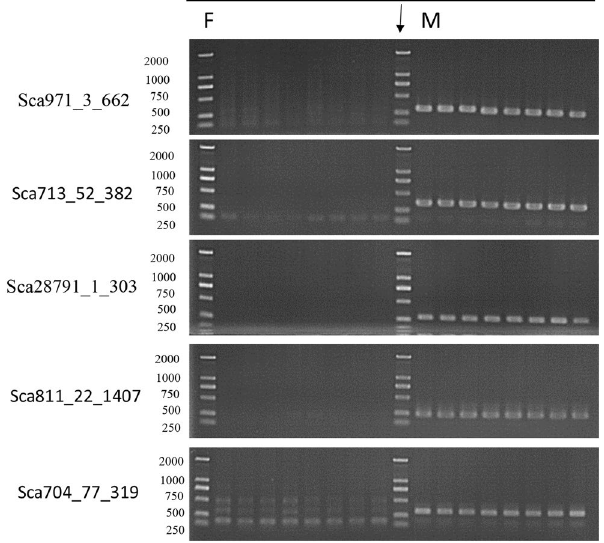
Figure 3. PCR tests for five representative Y-linked fragments in full-sib grass carp individuals. All five fragments that distributed in five significantly enriched scaffolds (Sca971, Sca811, Sca713, Sca28791, and Sca704) were selected in PCR tests in eight female and male grass carp samples. These five sequences are Sca971_3_662, Sca713_52_382, Sca28791_1_303, Sca811_22_1407, Sca704_77_319. Male specificity was defined as the occurrence of a clear amplicon of a distinct size in males but not in females. The DL2000 DNA Markers are loaded in the Lanes. The result verified that these five putative Y-linked scaffolds were Y-linked. Additional information of these five representative Y-linked fragments can be found in Table 3.